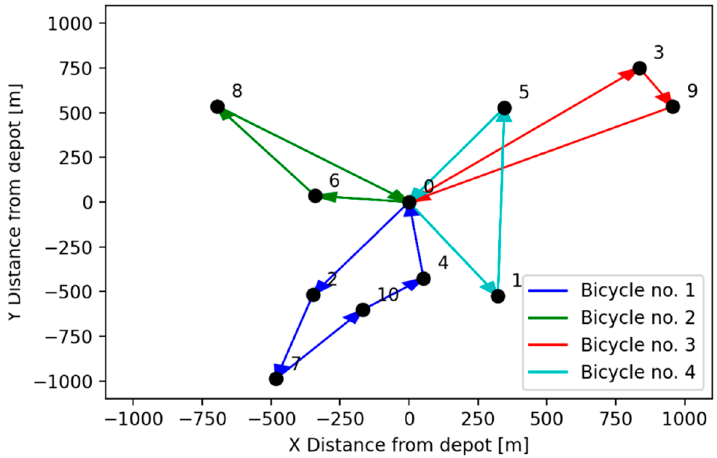
Figure 5. Route with best total travel time achieved from MTSP approach.